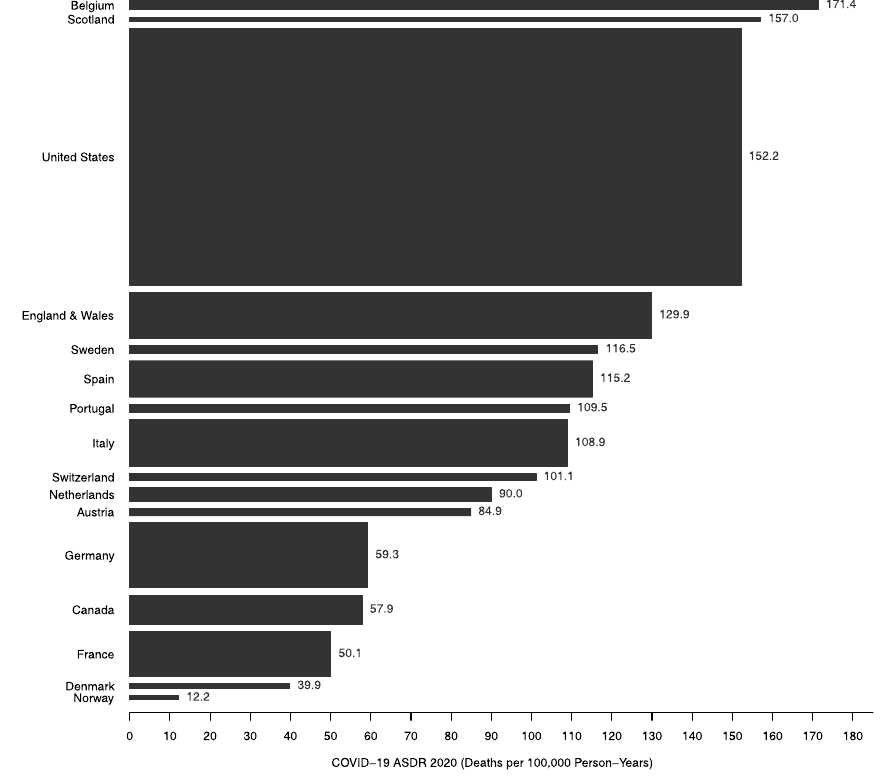
Fig. 2 Age-standardized death rate from COVID-19 in Europe and North America. Source: authors ’ calculations. Note: the height of each rectangle is proportional to the population size of each